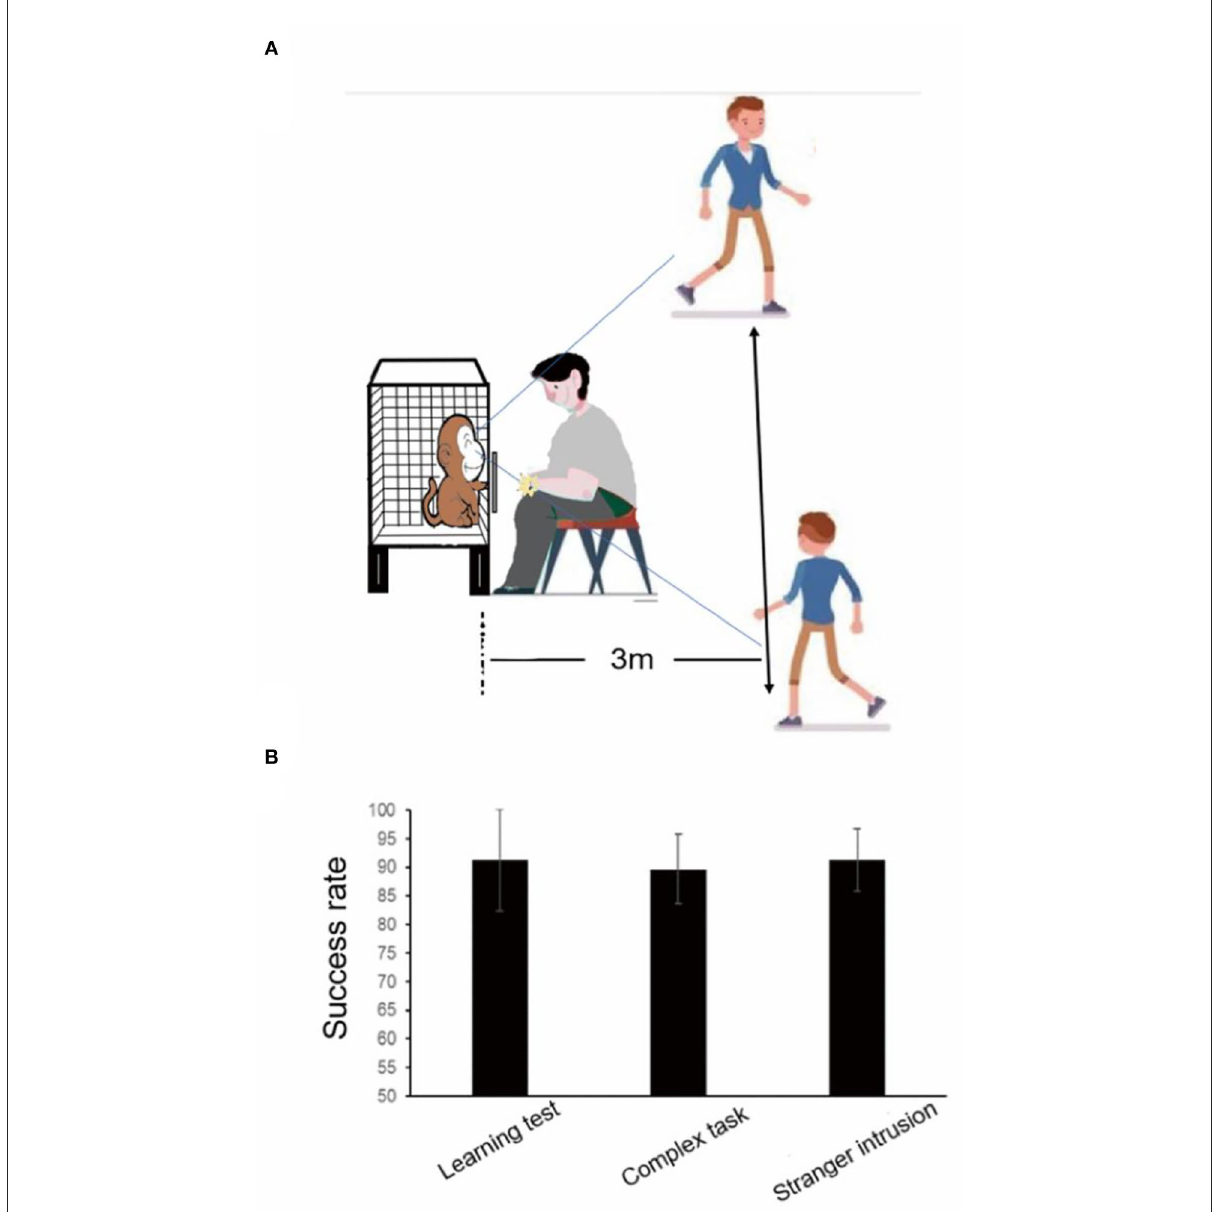
FIGURE5 Results of the learning test, the complex task test, and the stranger intrusion interference test before audio-visual stimulation. (A) The stranger intrusion interference test paradigm. (B) There was no statistically significant difference between the learning test and the complex task test and the stranger intrusion interference